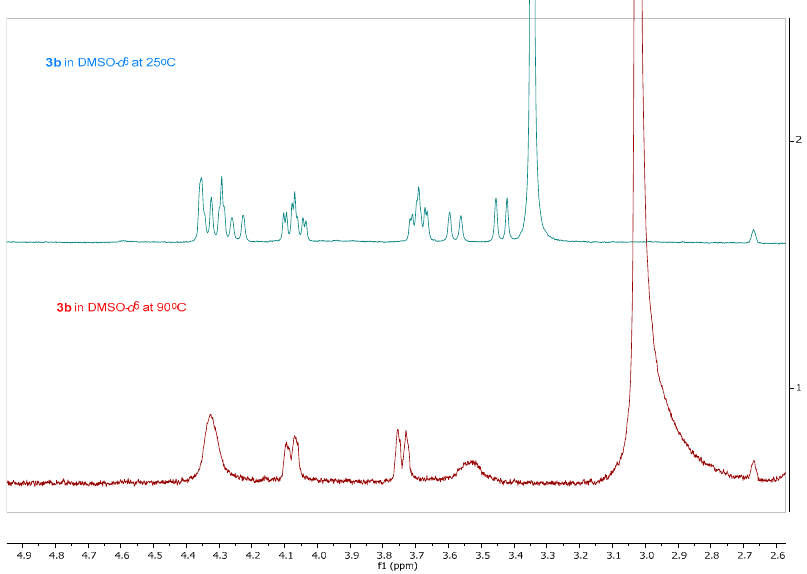
Figure 3. 1 H-NMR (400 MHz, CDCl 3 ) of 3b in DMSO- d 6 at 25 °C (blue) and 90 °C (red). The cyclopropanation reaction has two steps, ylide addition to the double bond and ring closure. It is known that the sulfur ylide attack is nonselective, and the exo:endo selectivity is determined in the second step [29–31]. The result depends on many different issues, such as temperature, reagent concentration, and the presence of a base. For instance, in the cyclopropanation reaction of 2a , the 15:1 exo:endo ratio was observed when carrying out the reaction at 0 ◦ C and a low concentration of ylide (0.15 M), while a higher temperature and ylide concentration promoted higher ratios in favor of an exo isomer. In the case of the cyclopropanation of compound 2b with an ylide concentration of 2M and temperature of 20 ◦ C, the ratio of exo/endo isomers can increase up to 20:1, as seen by NMR. Similar behavior has already been reported